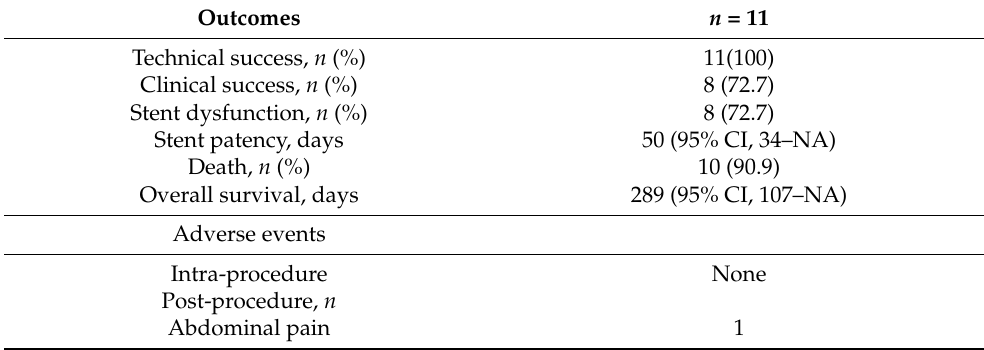
Table 2. Outcomes and adverse events of endobiliary radiofrequency ablation for hilar